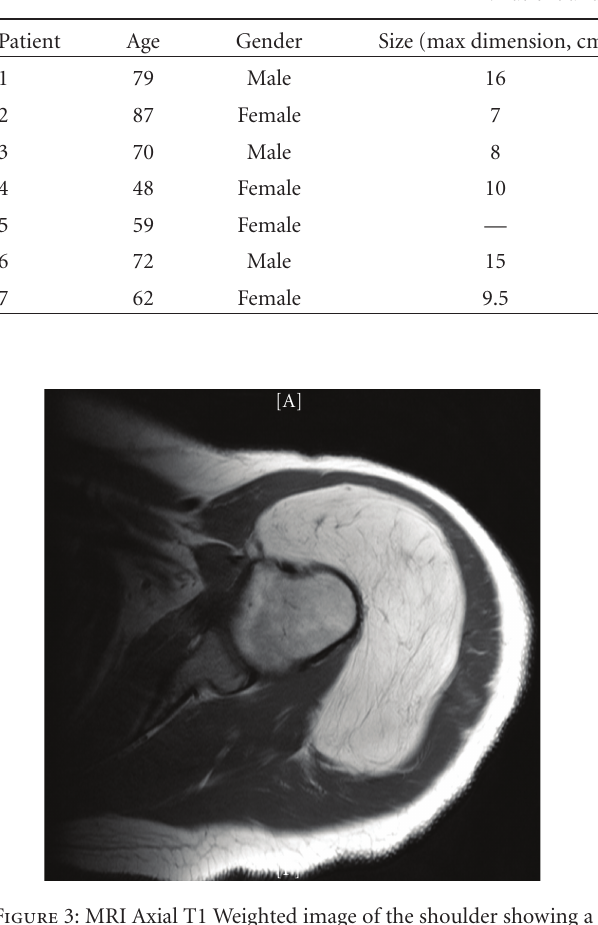
Figure 3: MRI Axial T1 Weighted image of the shoulder showing a large lipomatous tumour in the sub-deltoid